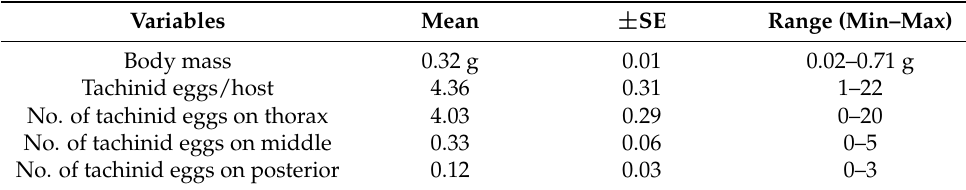
Figure 3. Distribution of collected CEW larvae according to their body mass and categorization of larval instar. Red dashed lines indicate approximate boundaries between instars. The number of tachinid eggs per host was unrelated to host mass (Figure 4, t = − 0.47, df = 198, p = 0.63), but varied significantly across body regions (F = 154.5, df = 2, p < 0.001),